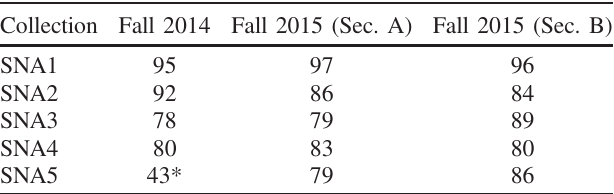
TABLE II. Response rates to the Fall 2014 and Fall 2015 SNA surveys. The unusually low return on survey SNA5 from Fall 2014 was likely due to the optional nature of the review session class when the data collection took place. These data were therefore disregarded from the analysis.